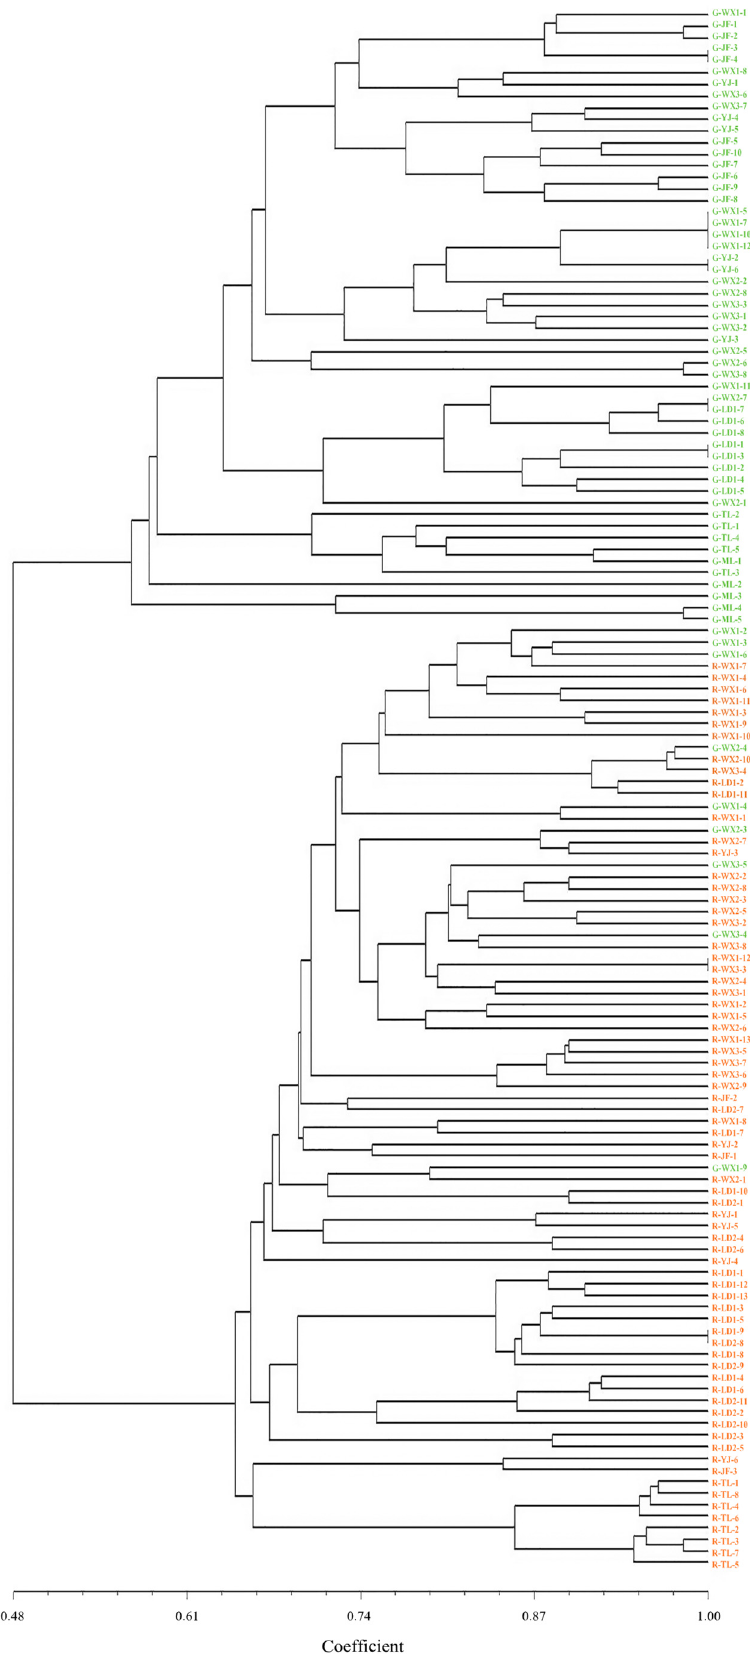
Figure 6. UPGMA tree of individuals based on genetic distance.